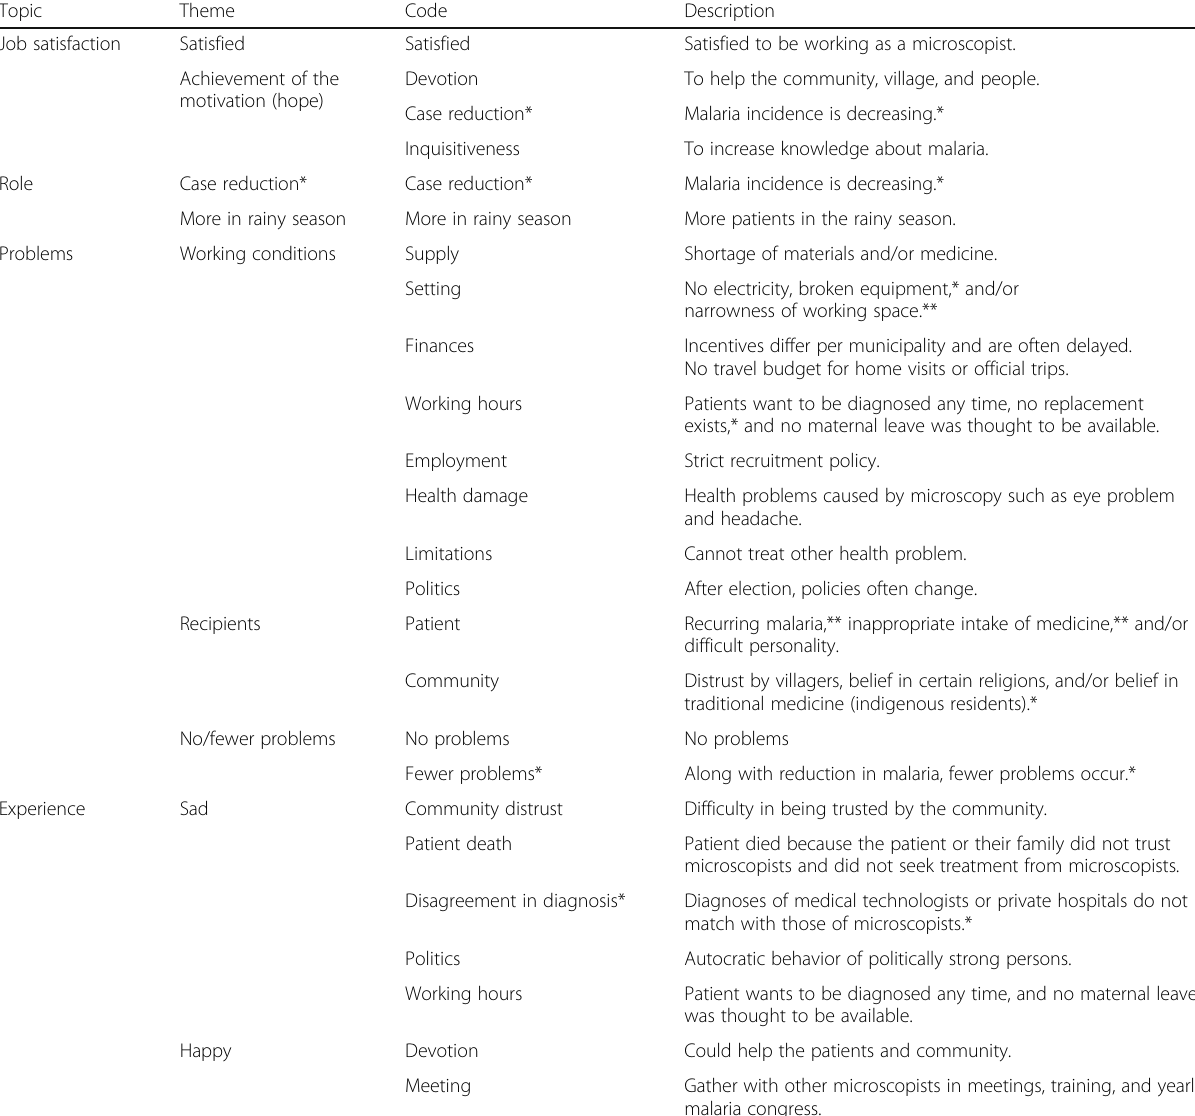
Table 5 Analytical framework of perception of the present (job satisfaction, role, problems, and experience) Topic